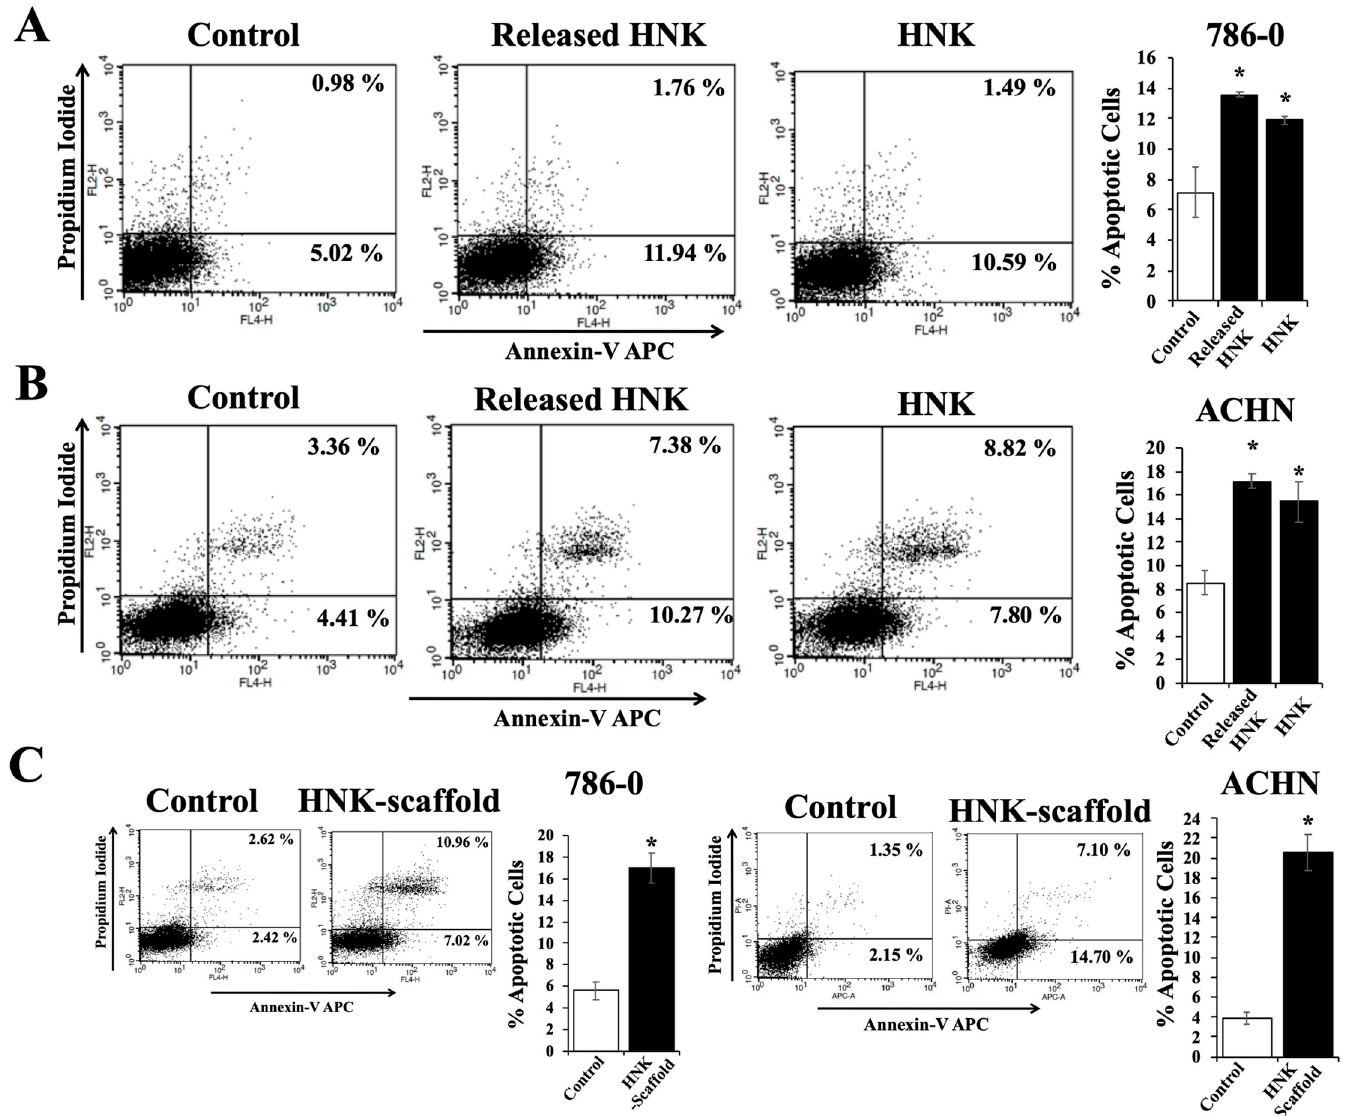
Fig 3. Apoptosis-inducing activity of Honokiol released from Honokiol-loaded PLGA 85–15 scaffold. (A) and (B) Renal cancer cells (786–0 and ACHN respectively) were treated with either the released Honokiol (20 μ M) or Honokiol (20 μ M) along with control for 24 hr. Following treatment, cells were stained with Annexin-V-APC and propidium iodide and the apoptotic indices were analyzed by flow cytometry. (C) Similarly, apoptotic indices of 786–0 and ACHN cells cultured with either 0.5x0.5 cm 2 Honokiol-loaded PLGA 85–15 scaffold or control scaffold for 24 hr were analyzed. The bar graph presented next to the flow cytometry dot-plots represents the percentage of total apoptotic cells (early + late). A, B, and C results shown are representative of three independent experiments. The columns in the bar graphs represent the mean ± S.D. of experimental readings. � , represents p < 0.05 compared with respective controls.